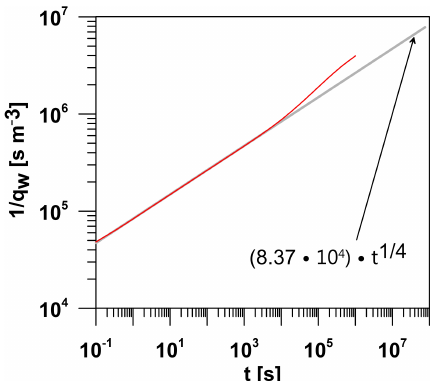
Figure 9. 1 /q w (sm − 3 ) vs. t (s) on a log–log scale. The synthetic curve is represented by the red line and the bilinear fit curve is dis- played with the grey line.